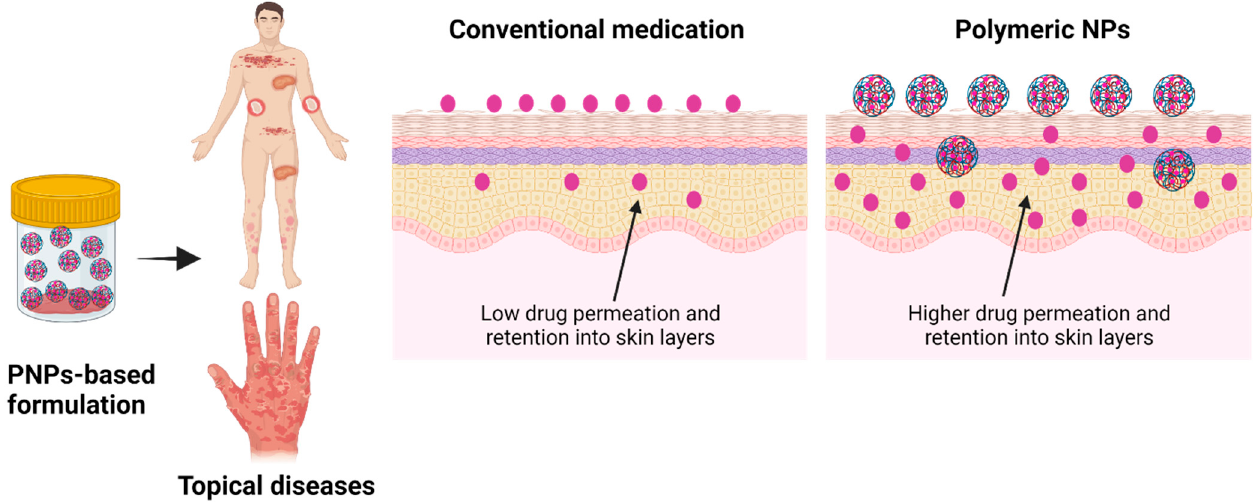
Figure 3. Increased permeation efficiency of PNPs through the skin and retention into various skin layers. Created with BioRender.com (accessed on 4 February 2023). layers. Created with BioRender.com (accessed on 4 February